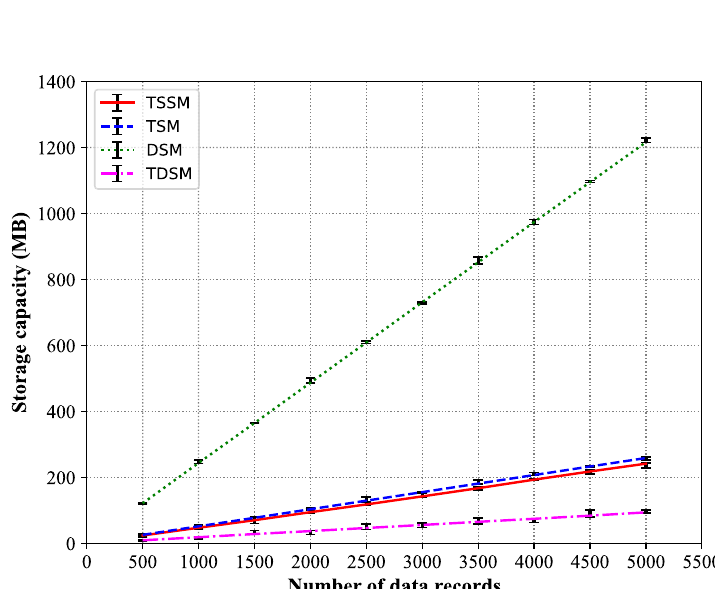
Figure 11. Comparison of storage capacities between TSSM, TSM, DSM and